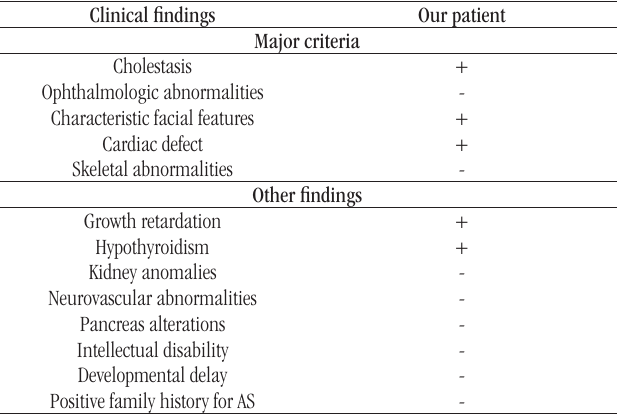
taBLE − Overview of the clinical findings of AS compared with those found in our patient Clinical